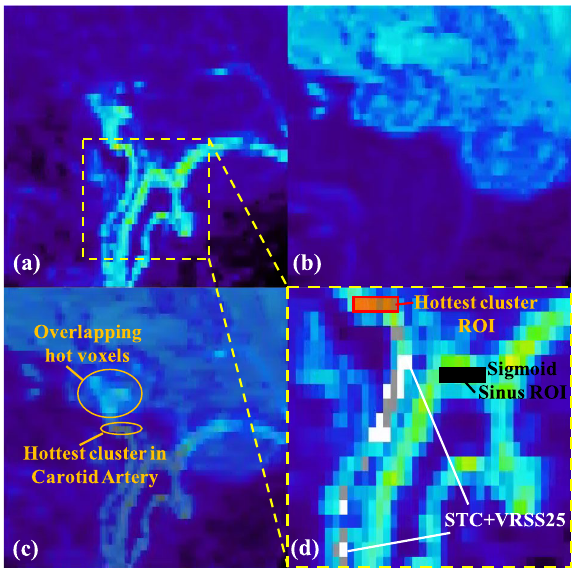
Fig. 6 One of the two side sagittal MIPs reconstructed using the proposed PSF‑HYPR4D‑K‑TOFOSEM from a the first 1 min of the FDG scan, b the last frame (50–60 min), c fusion image of ( a ) and ( b ) indicating the voxels excluded by simple exclusion, and d zoomed in sagittal MIP focusing on the ROI’s used in the analyses (note that STC VRSS50 voxels are indicated by STC VRSS25 voxels plus the grey + +